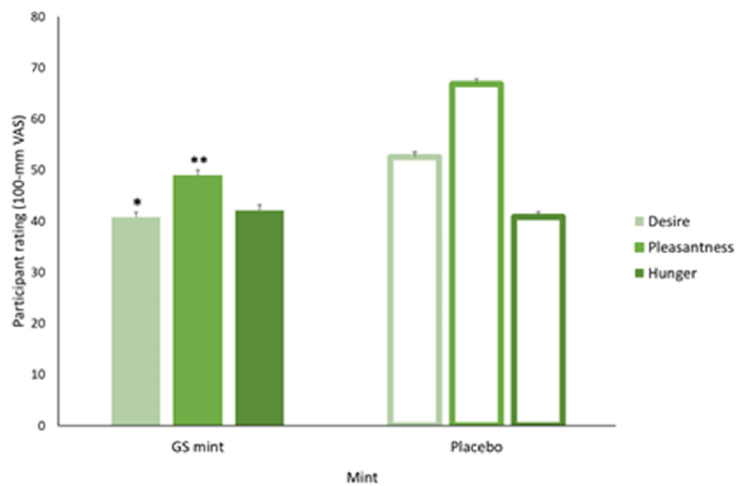
Figure 2. Participants’ ratings for desire (for more chocolate servings), pleasantness of eating and hunger for the first chocolate serving following consumption of gymnema and placebo mints ( n = 56). Ratings were assessed using a visual analogue scale of 0–100 mm. The scale for desire for more ranged from 0 mm = not at all to 100 mm = yes, very much . Pleasantness ratings were anchored by 0 mm = not at all pleasant and 100 mm = very much pleasant . Hunger was rated from 0 mm = I am not hungry at all to 100 mm = I am extremely hungry . * significantly different to placebo ( p < 0.05); ** significantly different to placebo ( p < 0.001).